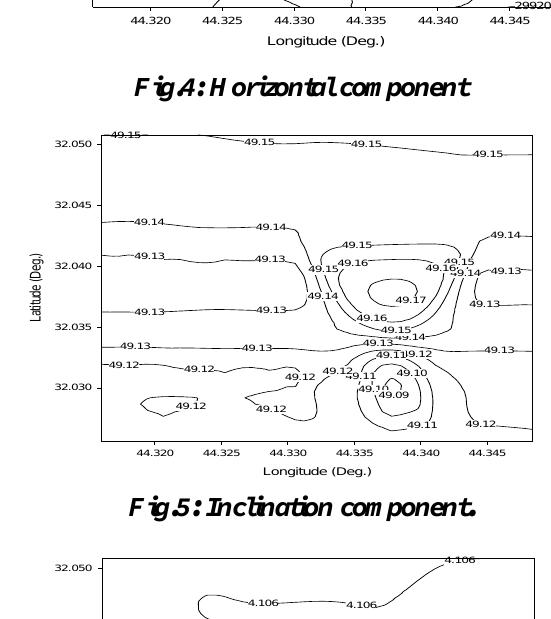
Fig . 5 : Inclination component .